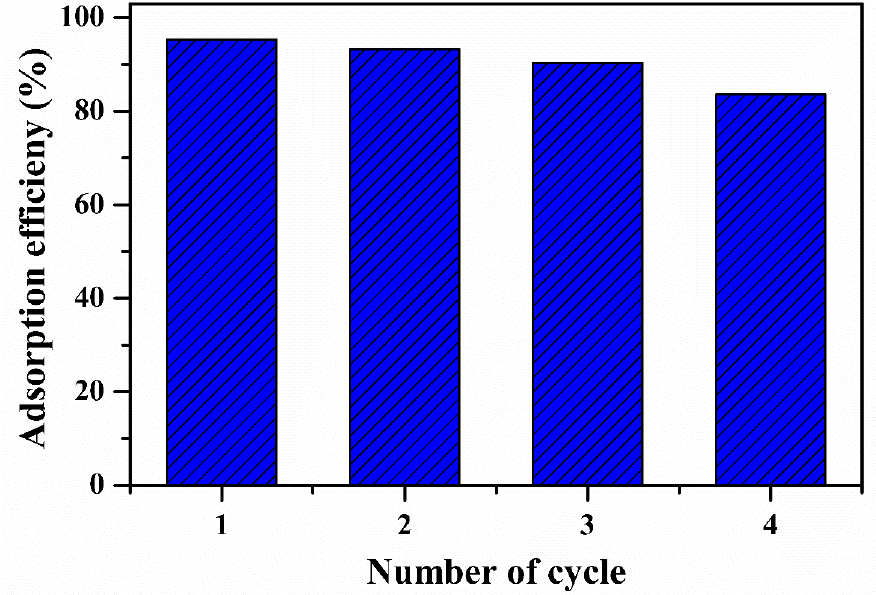
Figure 16. Regeneration of OPB / MWCNTs reinforced PVA hydrogel composite for the adsorption e ffi ciency of Pb(II) at room temperature.